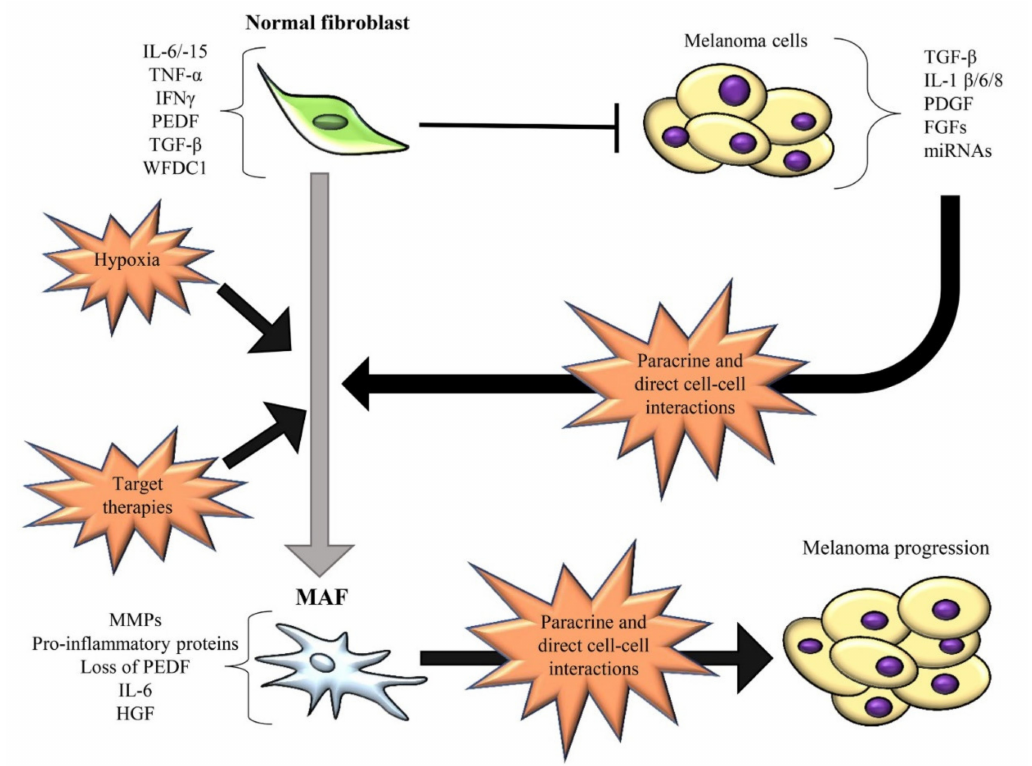
Figure 1. Schematic representation of the bidirectional interactions between normal fibroblasts or melanoma-associated fibroblasts (MAFs) and melanoma cells. The main soluble mediators involving in this crosstalk are reported. Normal fibroblasts can inhibit the growth of melanoma cells. IL-6/-15, TGF- β , PEDF, TNF- α , IFN γ and WFDC1 are produced by normal fibroblasts and associated with melanoma inhibition. Concurrently, normal fibroblasts are forced by melanoma cells to acquire a constitutively activated state and differentiate into the tumor-promoting MAFs. MAF differentiation occurs in the tumor mass through melanoma cell-derived soluble factors (such as TGF- β , IL-1 β , PDGF, FGF, miR-155/-210/-211) or direct cell–cell contacts. In turn, MAFs secrete soluble mediators (such as pro-inflammatory proteins, MMPs, IL-6, HGF, etc.) leading to melanoma growth and progression. Of note, IL-6 and TGF- β act as tumor suppressors at early stage of melanoma and tumor promoters at late stage. Other conditions promoting MAF differentiation are represented by hypoxia and target therapies (such as MAPKi). Black T bar represents inhibition, while black arrows depict induction. The transition from normal fibroblasts to the tumor-promoting MAFs is indicated by the grey